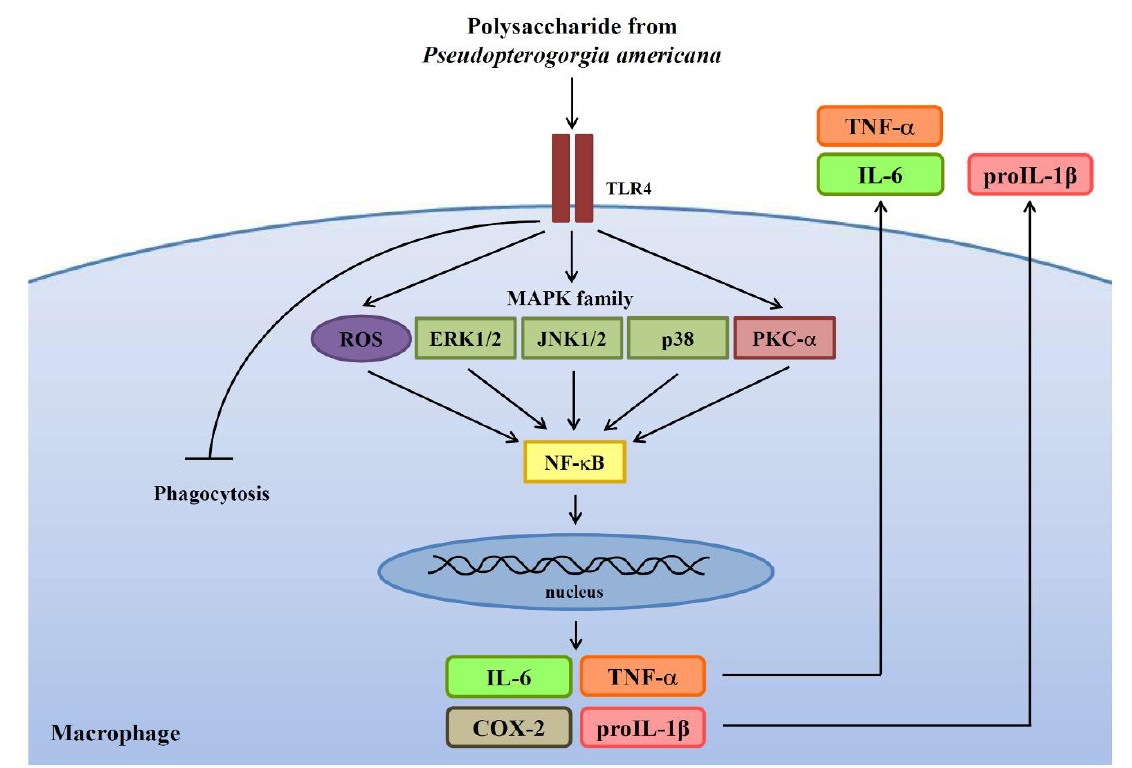
Figure 10. Overview of the putative mechanisms by which PPA activated macrophages.